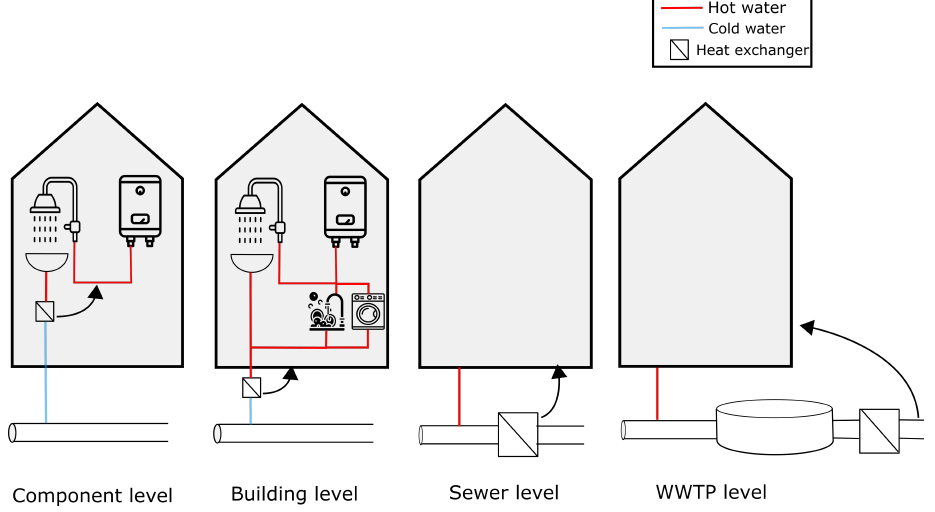
Figure 1. Possible options of heat recovery from wastewater